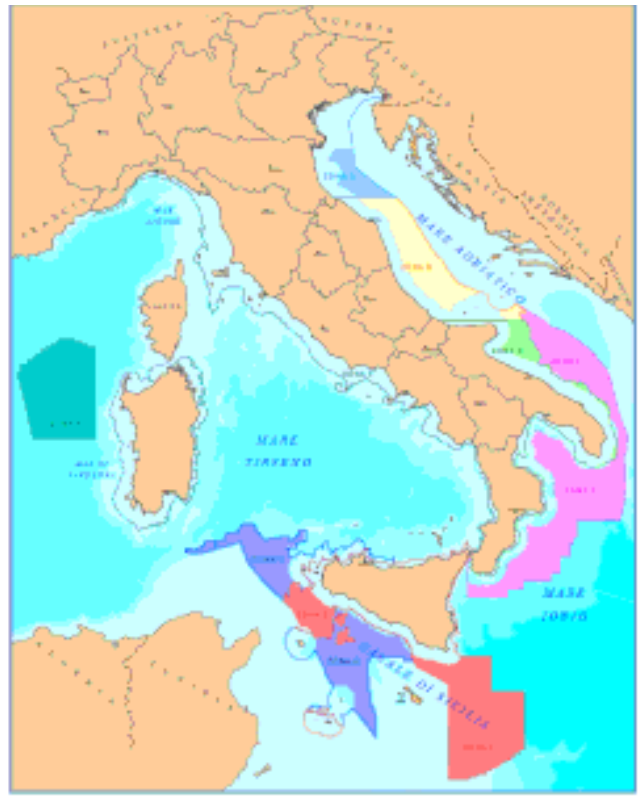
Figure 1. Production of natural gas from drilling concessions within 12 miles, with licenses expiring in the next years [1].